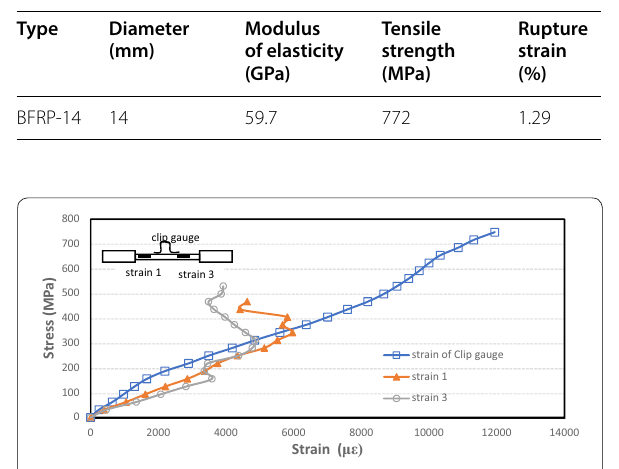
Table 2 Mechanical properties of the BFRP bars.